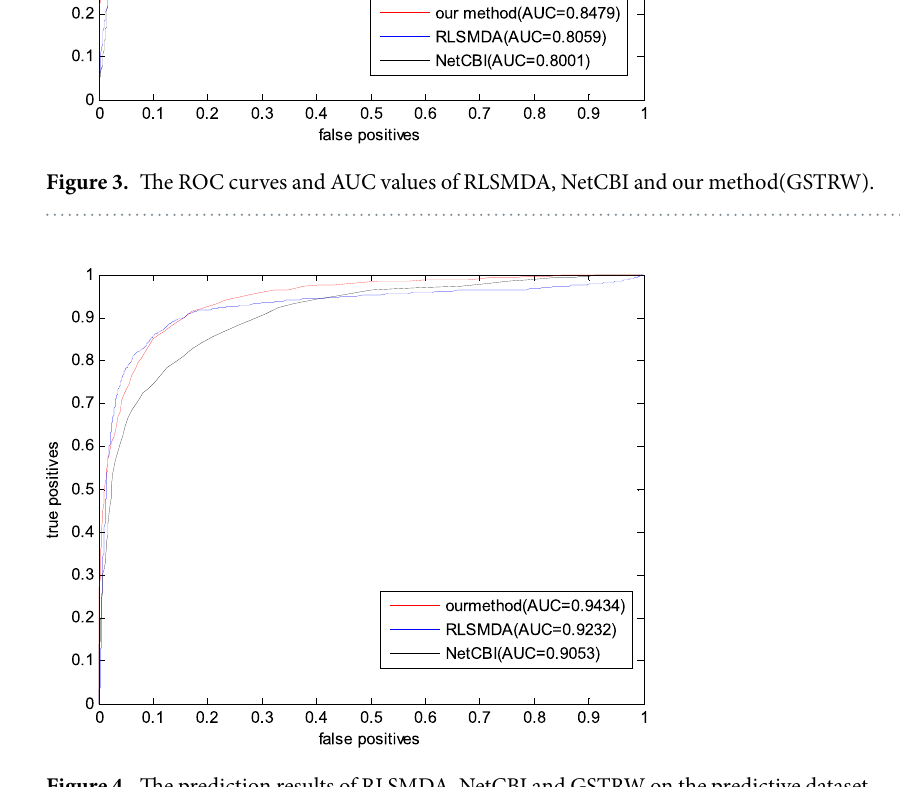
Figure 4. The prediction results of RLSMDA, NetCBI and GSTRW on the predictive